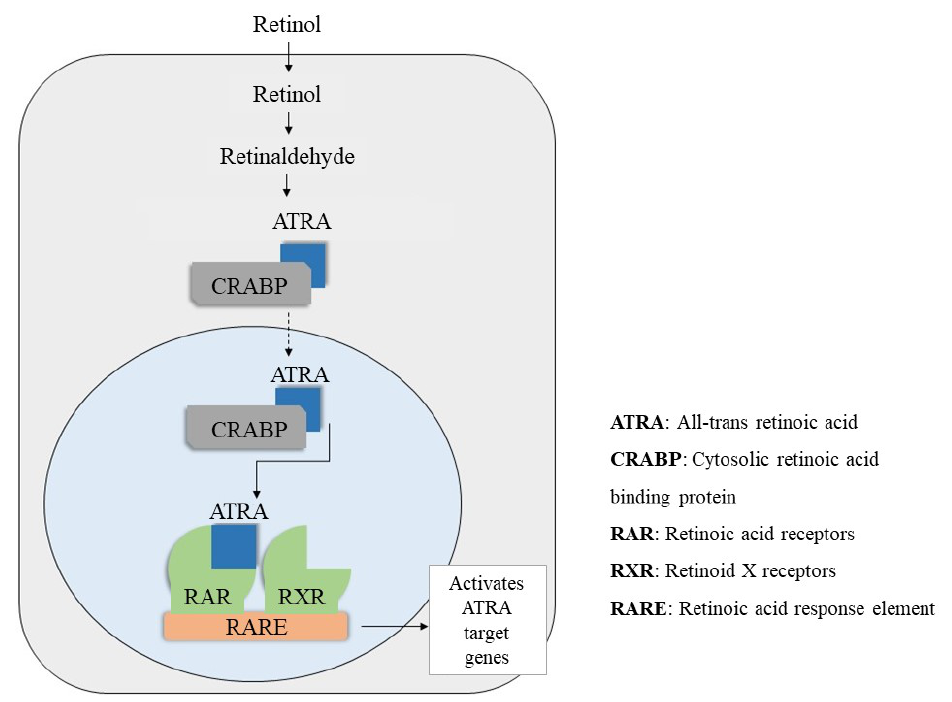
Figure 2. Illustration of the process of activation of retinoid nuclear receptors (RNRs) by all-trans retinoic acid.